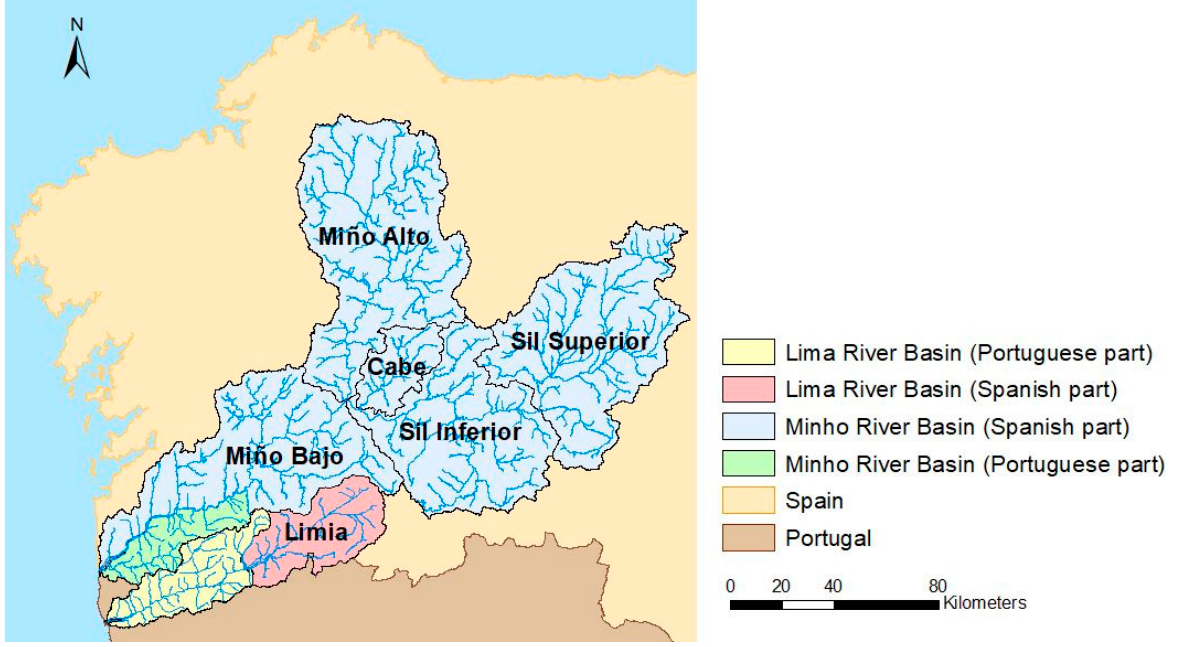
Figure 2. Portuguese and Spanish parts of the Minho and Lima river basins, with their corresponding Spanish territorial management units (TMUs) identified.